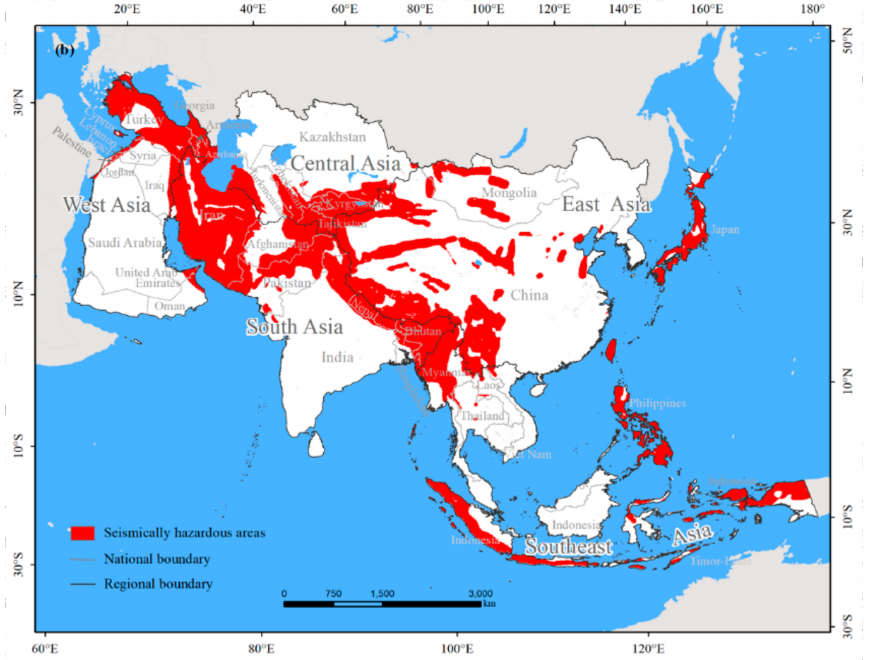
Figure 2. Seismic PGA map. ( a ) The PGA with a 10% probability of exceedance in 50 years; ( b ) The most seismically hazardous area (MSHA) with PGA values greater than or equal to 0.2